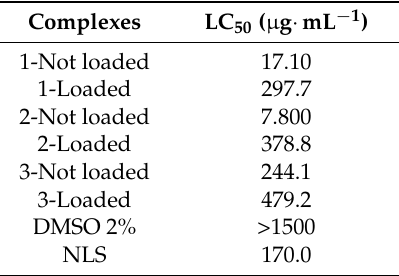
Table 5. Lethal concentration (LC 50 ) determined for free copper(II) compounds or those loaded into the nanosystem in Artemia salina